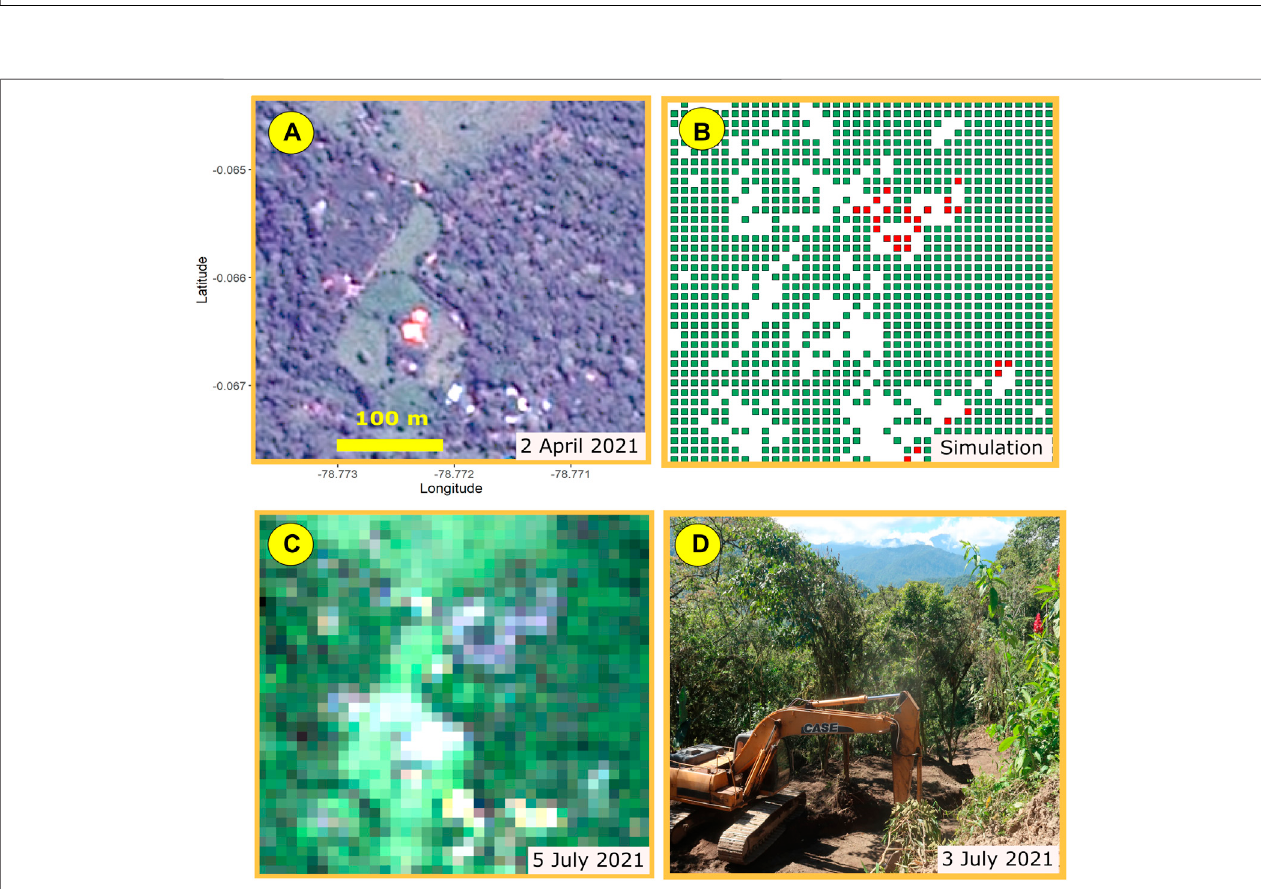
FIGURE 9 | (A) Airbus mid-resolution image of a Mindo tile for which (B) the model simulation showed tree cover loss in the tile. The Airbus image (taken on April 2021) does not show tree cover loss. But the model was based on a Sentinel raster (C) taken on July 2021. A site visit clari fi ed the discrepancy. Construction of a new subdivision broke ground (D) after the Airbus image was taken in April. Sentinel ’ s July image and the Random Forest model detected the more recent pattern of tree cover loss.